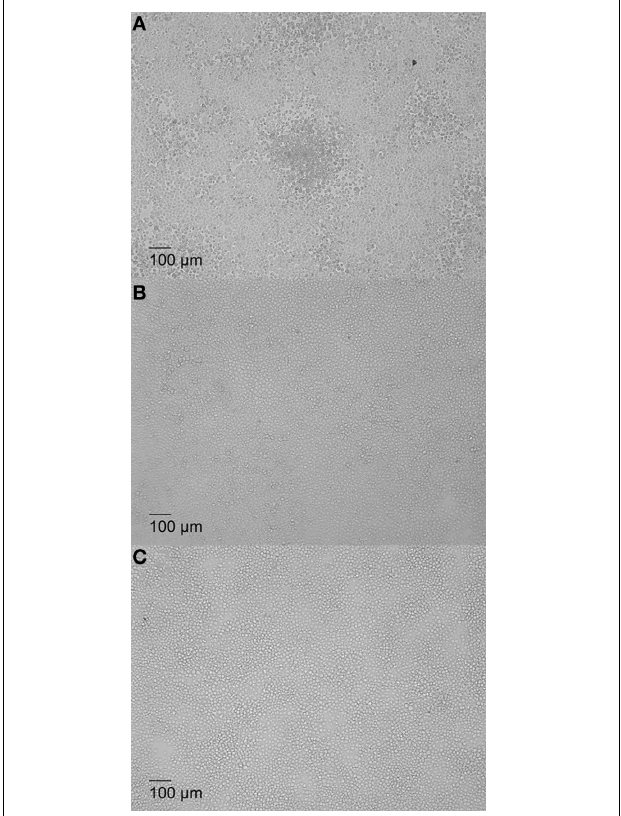
FIGURE 1 | Plaque formation in Brucella -infected macrophage monolayers associated with cytotoxicity. J774.A1 macrophages were infected at an MOI of 0.1 with B. melitensis mutant 16M (cid:2) manBA (A) , 16M (cid:2) manBA (cid:2) virB 2 0.1 (B) , or left uninfected, as control (C) . The agarose (1% w/v) overlay and DMEM were added at 1h p.i. as described in Materials and Methods, and incubated an additional 5 days. The cells were fixed overnight in 3.7% (w/v) formaldehyde and observed using IX70 microscopy. Scale bar, 100 μ m.